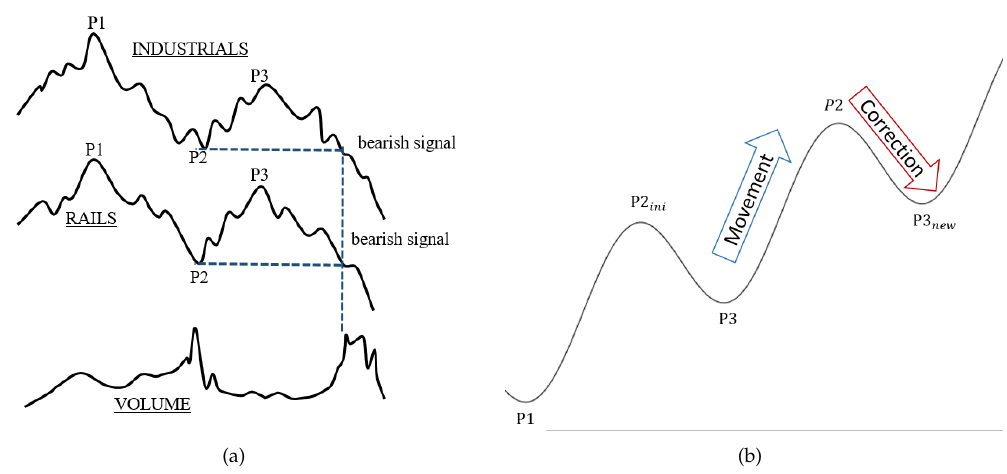
Figure 1. ( a ) Example of a down-trend in a historical setup as Dow used it (freely adapted from Russel [5]); ( b ) sketch of an up-trend in the sense of